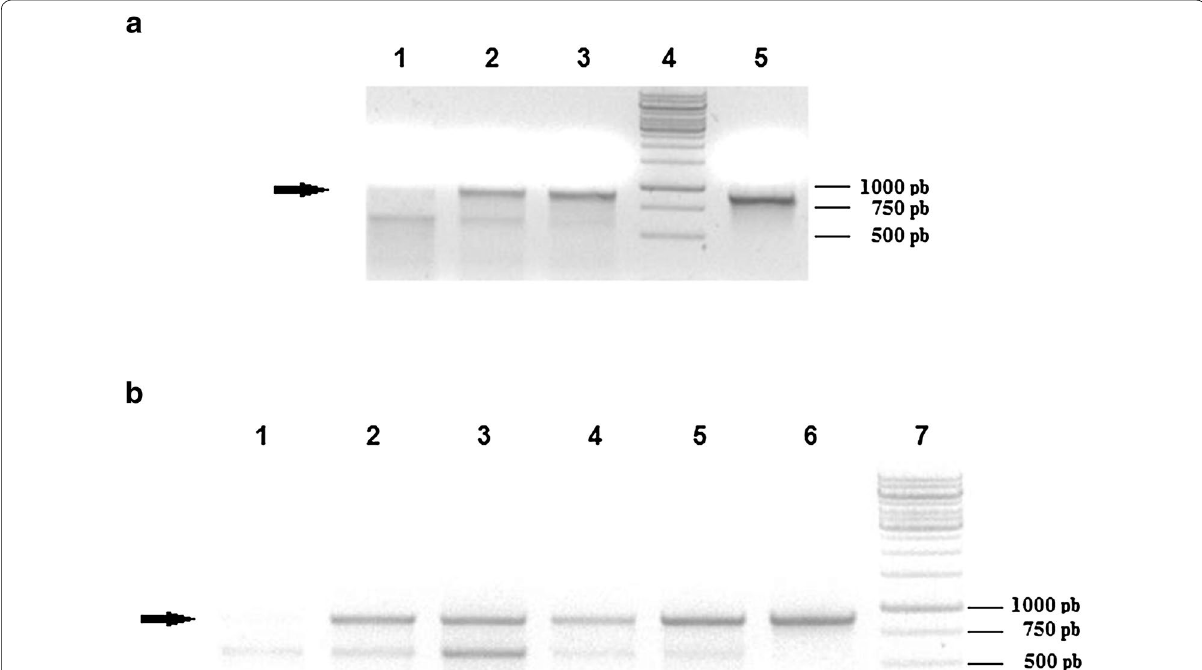
Fig. 2 Detection of the APA gene in transgenic tobacco plants. Genomic DNA was amplified with specific primers to detect an 871 bp fragment (indicated by an arrow) corresponding to the APA gene. a Lane 1: negative control; Lanes 2 and 3: transgenic plants; Lane 4: DNA size marker; Lane 5: positive control. b Lane 1: negative control; Lanes 2–5: transgenic plants; Lane 6: positive control; Lane 7: DNA size marker. The negative control was the amplification of the genomic DNA from wild-type plants; the positive control was the amplification from pCam-PSC-APA plasmid DNA and the DNA size marker used was the Gene Ruler 1 kB (Fermentas, USA)